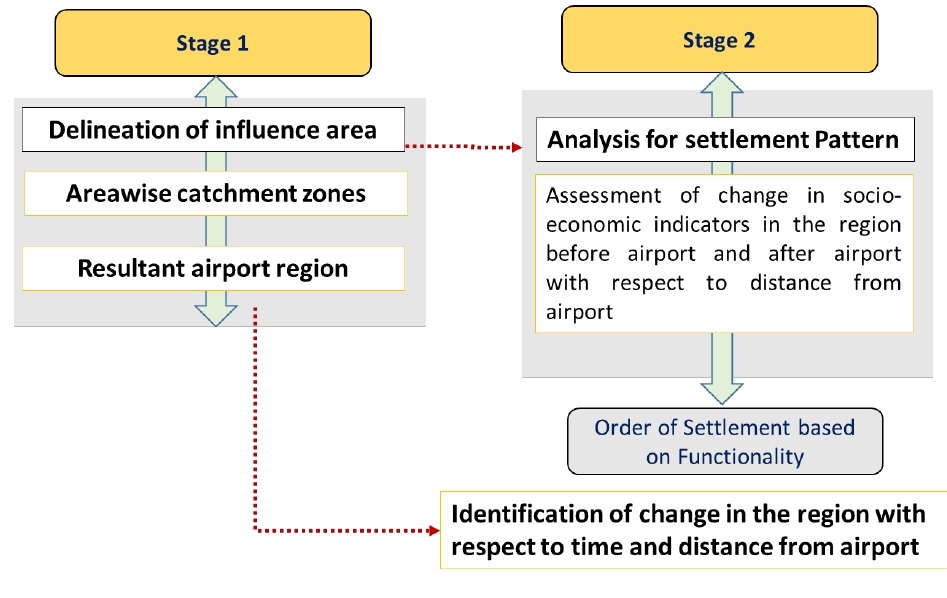
Figure 3. Study framework.